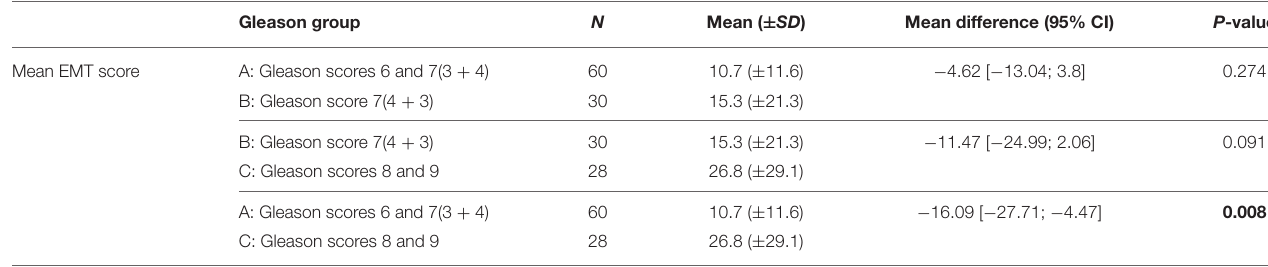
TABLE 3 | Comparison of the mean EMT scores between Gleason